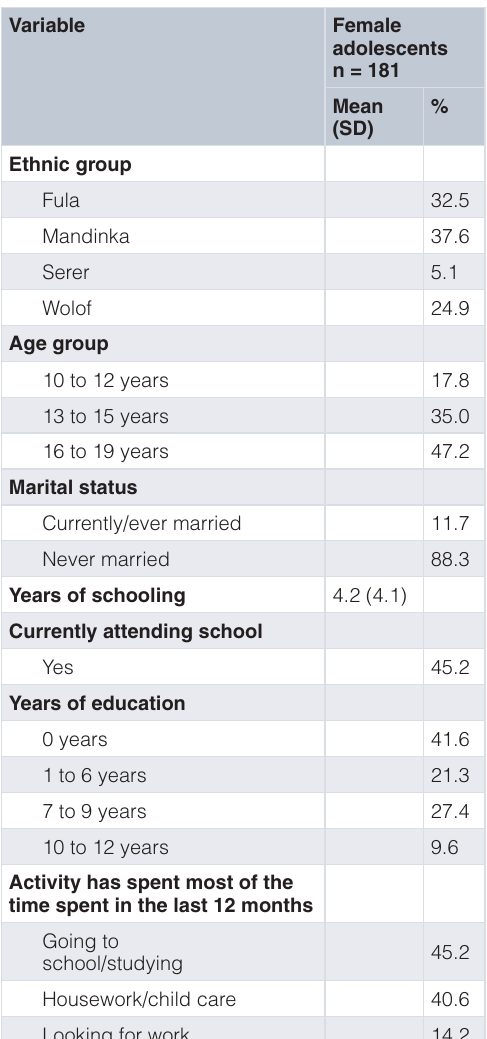
Table 3. Demographic characteristics of female adolescents aged 10–19